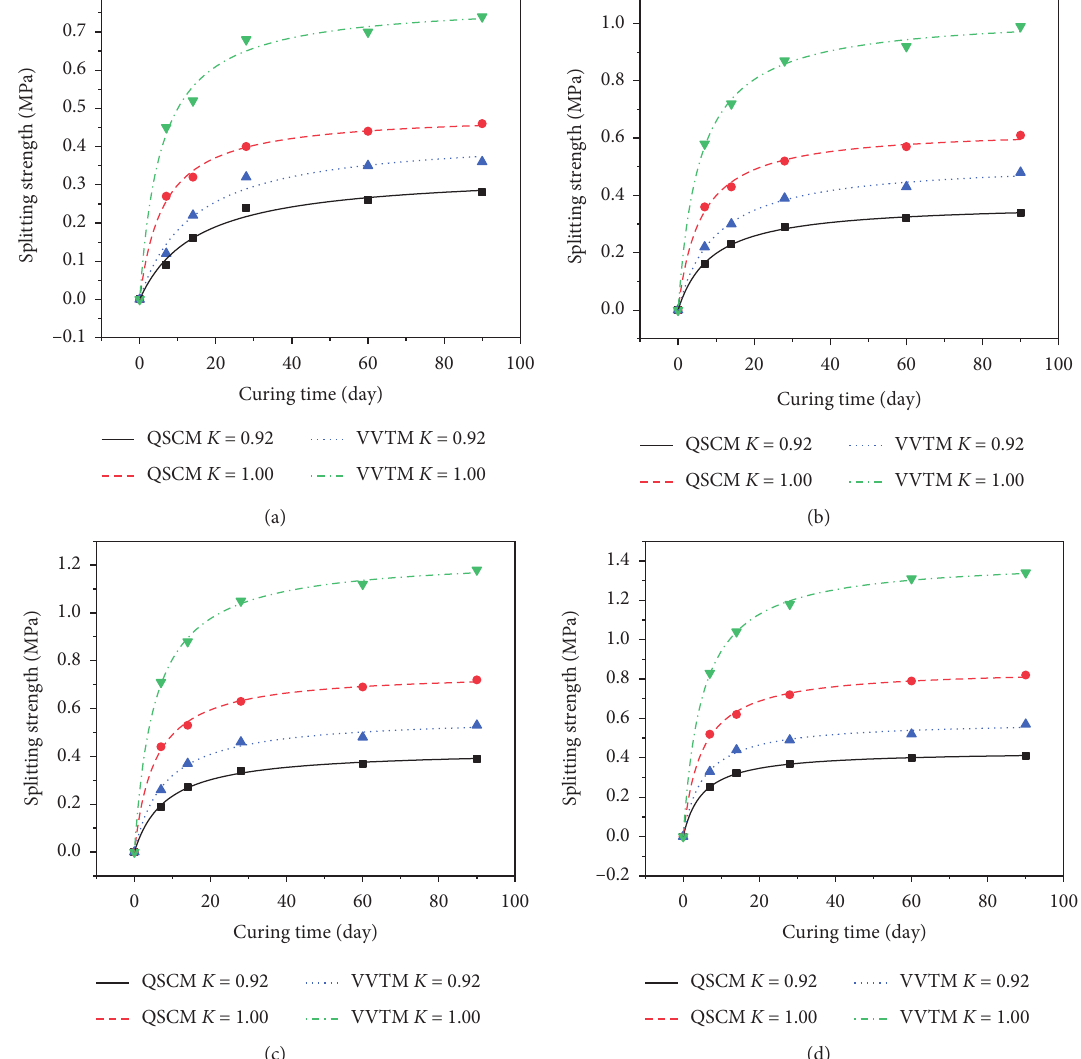
Figure 9: Influence of curing time on SPS of CSL compacted using VVCM and QSCM. (a) Cement content � 3%. (b) Cement content � 4%. (c) Cement content � 5%. (d) Cement content �